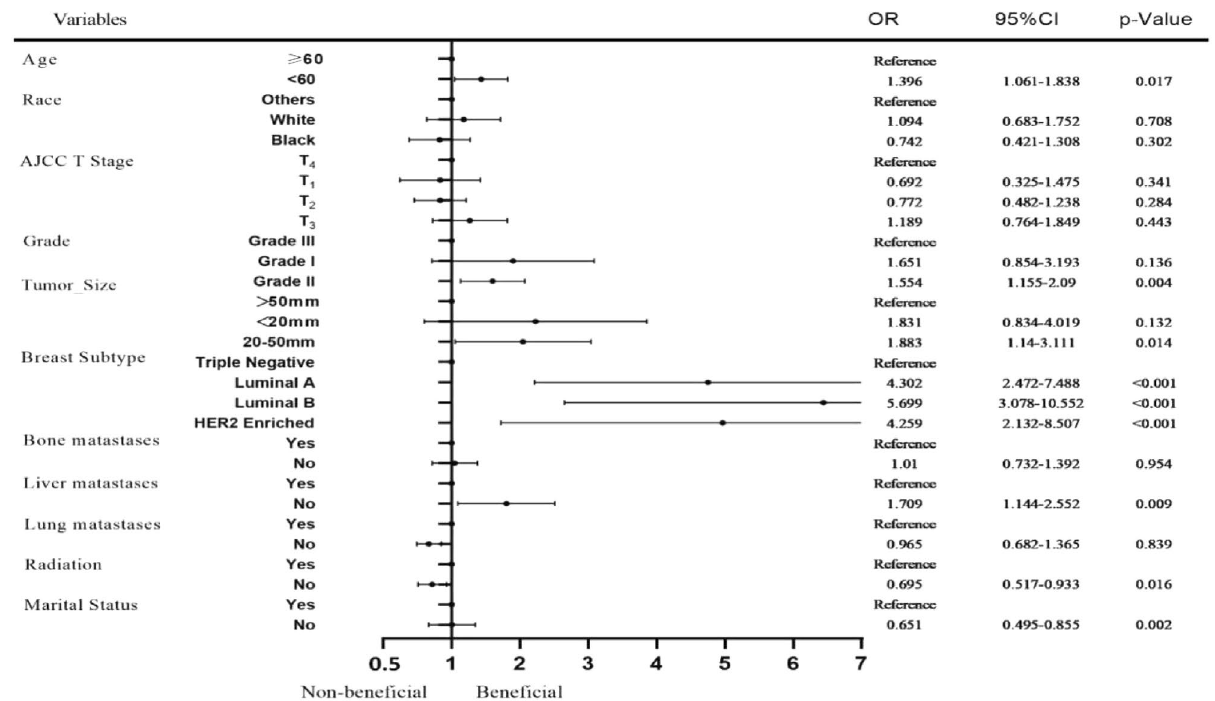
Figure 3. Forest plots of the multivariate logistic regression